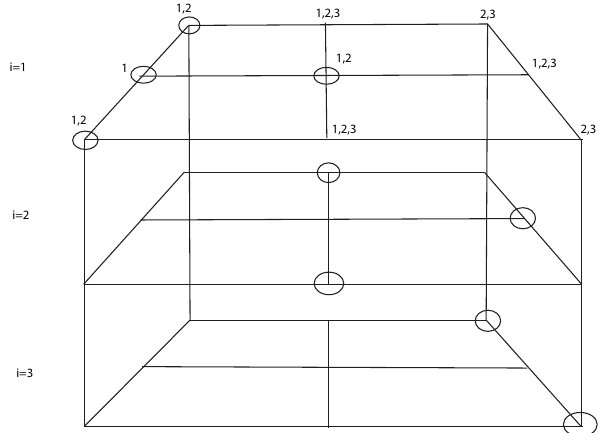
Figure 1. A hypothetical example depicting the construction of a single analysis member. Each level represents a different back- ground ensemble member (particle), with a model space composed of a 3 × 3 grid. The nodes of the grid are circled if the member is chosen for the construction of analysis member 1 by the LPF. The numerals indicate the IDs for the background members that will be averaged at the corresponding node, in this case, based on the im- mediately adjacent neighbor points of that